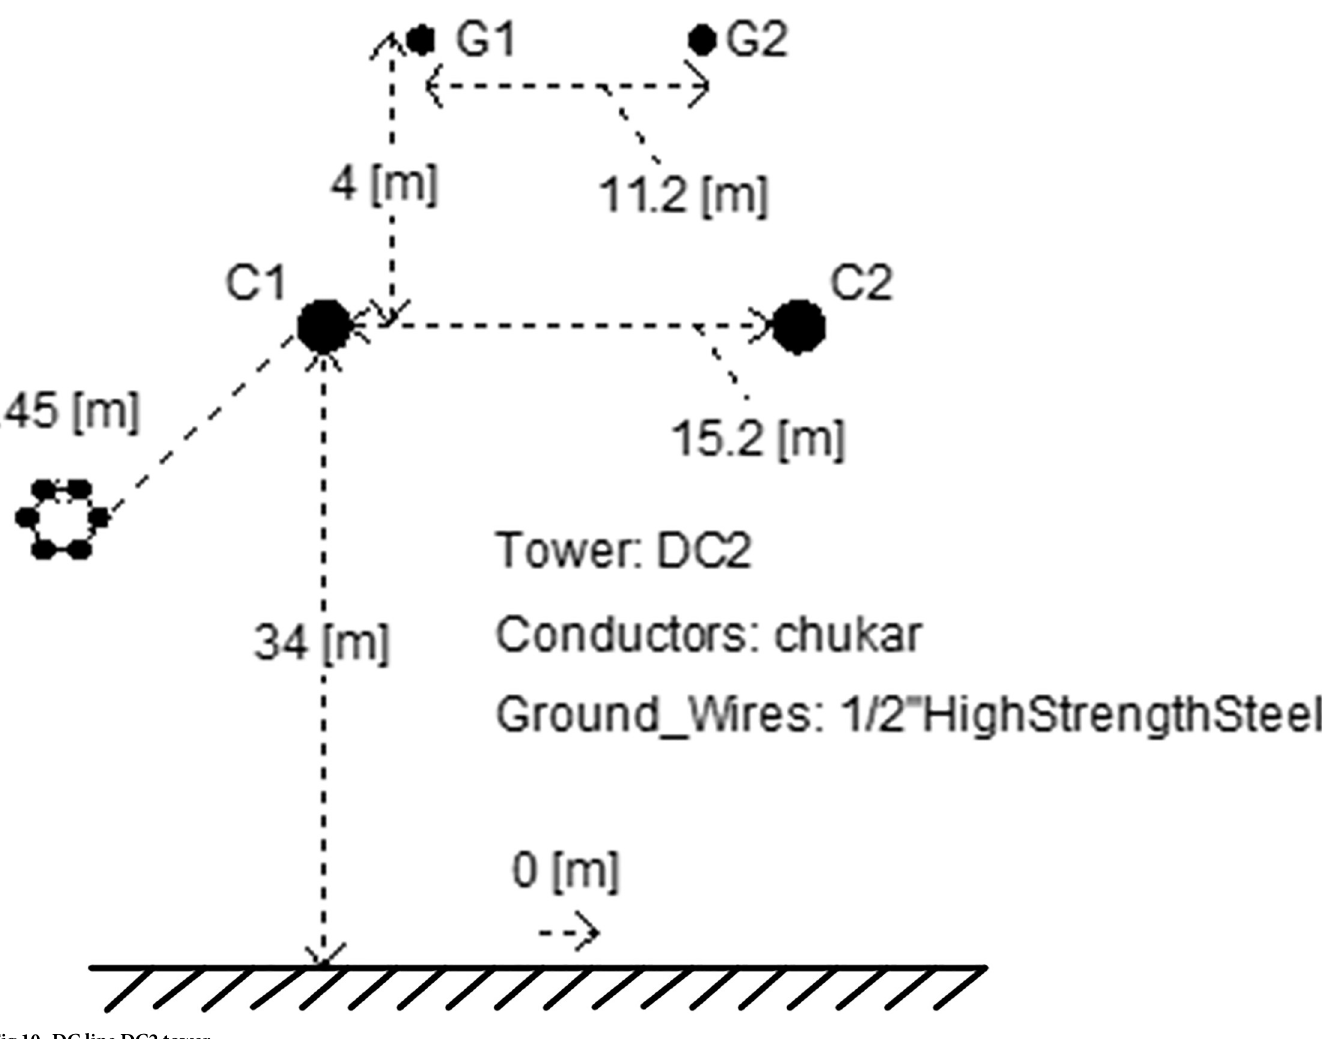
Fig 10. DC line DC2 tower.